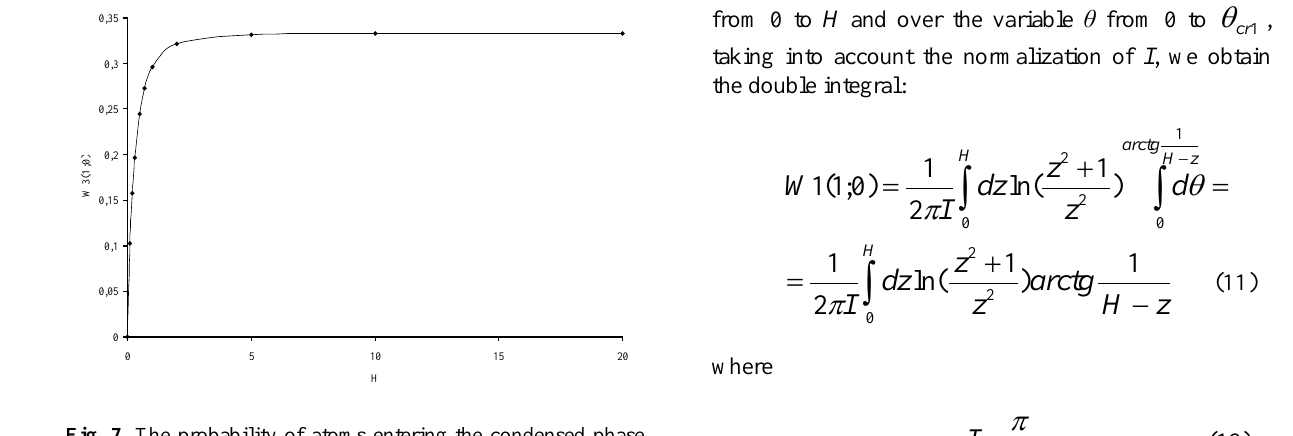
Fig. 7. The probability of atoms entering the condensed phase after a single collision with the walls.